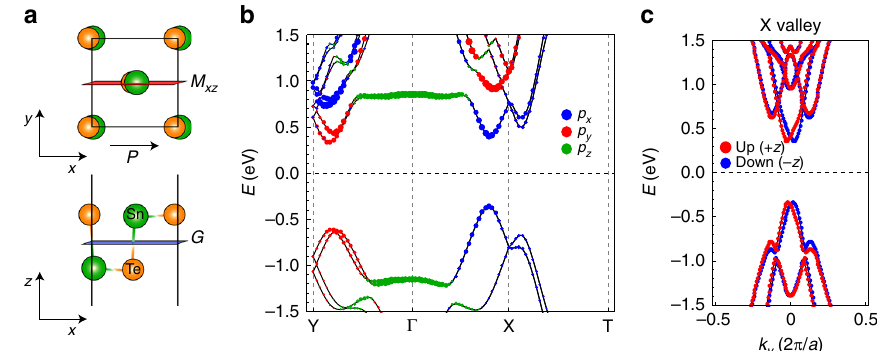
Fig. 1 Atomic and electronic structure of the SnTe monolayer. a Top and side views of the SnTe monolayer. The ferroelectricity is induced by the in-plane atomic movements of the Sn (green spheres) and Te (orange spheres) atoms. M xz and G denote the planes for the mirror symmetry and the gliding symmetry, respectively. b The calculated band structure of the SnTe monolayer. The states near the Fermi levels are mainly composed of p orbitals and their weights are plotted in three colors. c The calculated band structure for the X valley. The band calculation is performed along the k y -direction for the X valley. Spinup (spindown) states are marked by red (blue) dots. Due to the inversion symmetry breaking induced by the ferroelectricity, a Rashba-type unidirectional spin texture appears in the band